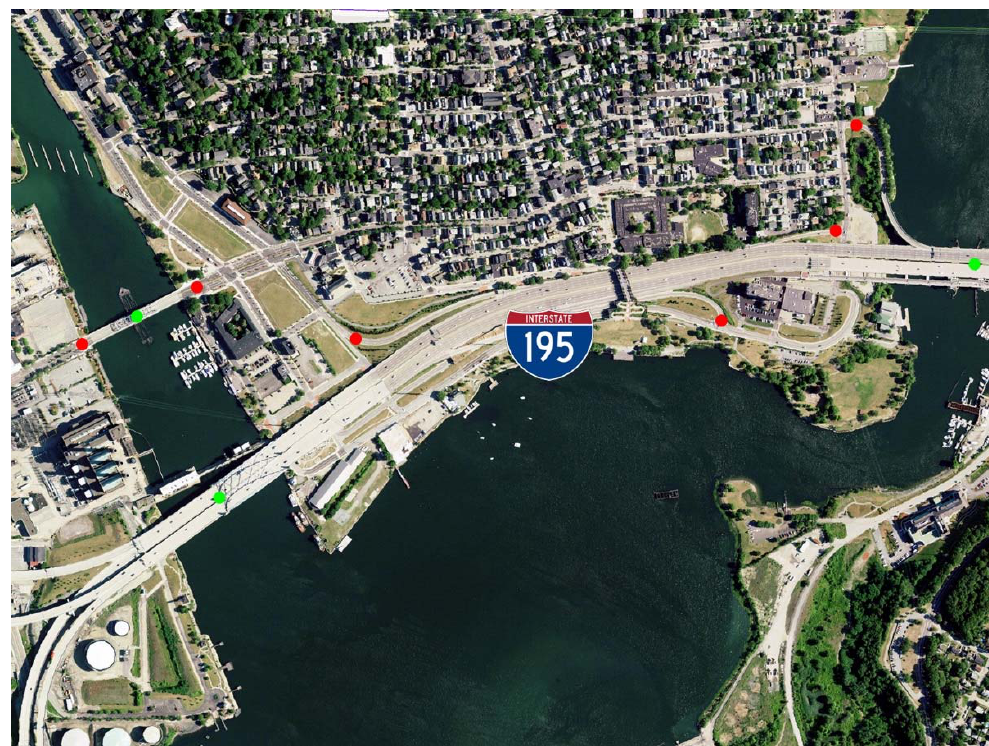
Figure 13. Comparison of points located at highway access ramps and bridge ends ( red points ) to span centers ( green points ). Before being corrected, span elevation was recorded as the channel bottom (bathymetry). A more logical way to determine whether a span would be compromised would be to ascertain elevation based on the underside of the span (direct impact/shear failure) or at pier locations (scour) [32,33]. Image: Authors (Air photo: